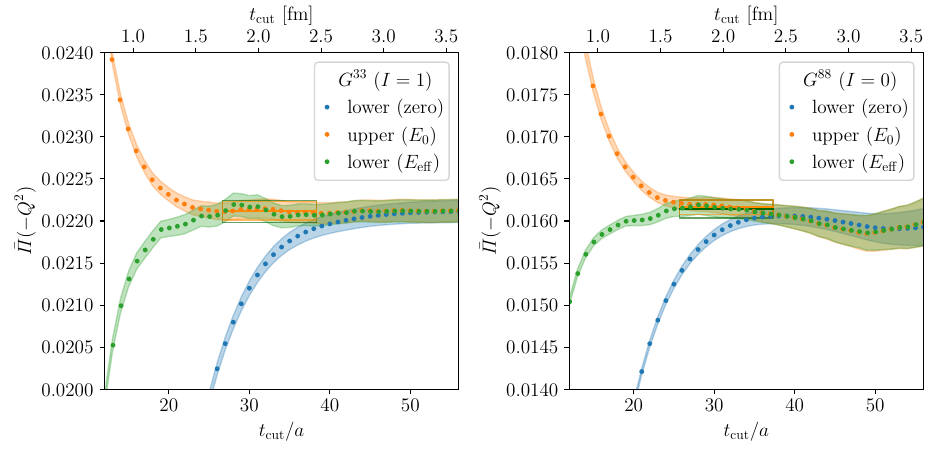
Figure 3 . Bounding method on the I = 1 (left) and I = 0 (right) components for ensemble D200 at Q 2 = 0 . 5 GeV 2 . The upper bound (orange points and band) is chosen as the ground state obtained from the finite volume analysis (left) or as the ρ meson mass (right). The lower bound (green points and band) is computed using the effective mass at every time slice. The time slices on which the upper and lower bound are averaged are indicated by the limits of the average lines and error boxes. The less stringent lower bound given by the integral truncated up to t is also given (blue points and